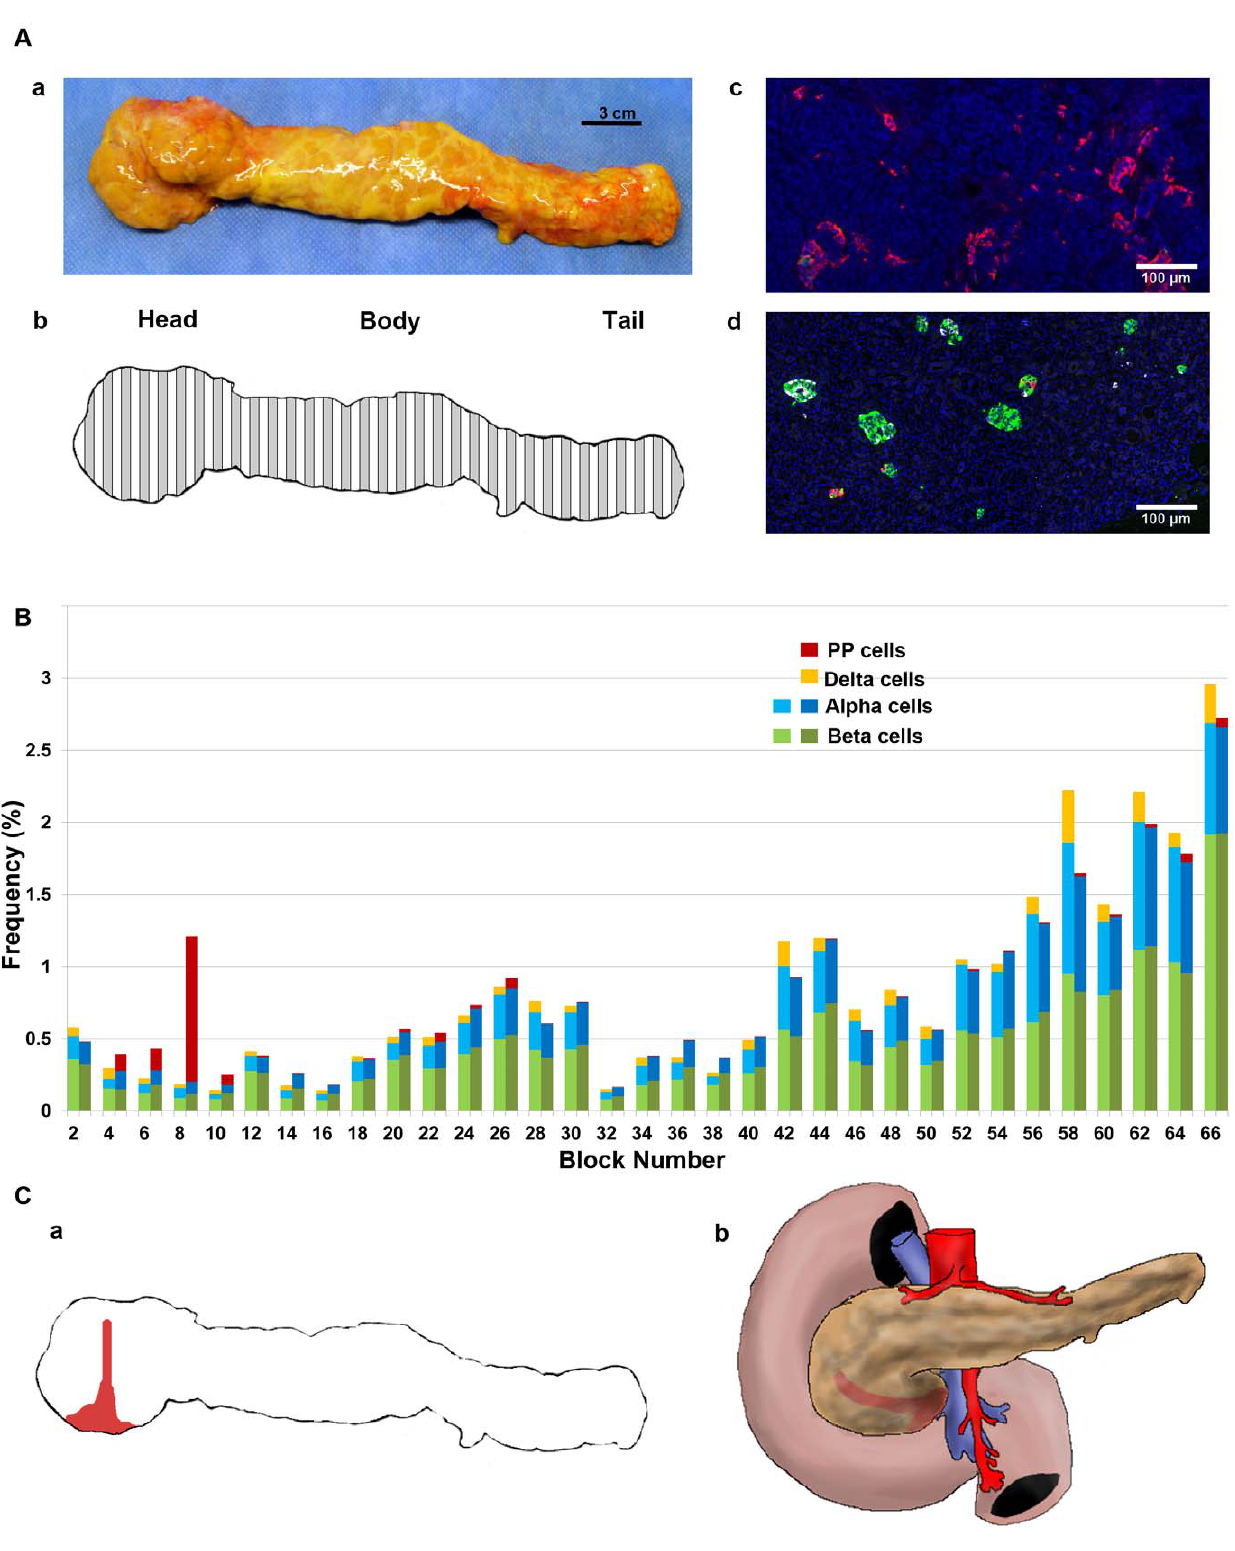
Figure 1. Whole pancreas analysis of the PP-cell distribution. A : a . A pancreas from a 50-yr old male; S5). b . Collection scheme. Specimen divided into 66 consecutive sections, with preparation alternating between fresh-frozen (white) and paraffin embedding (grey). The latter set of tissue blocks was used in the present study. c . Representative view of the PP-cell rich region with irregularly shaped clusters of PP-cells. Immunostained for PP (red), insulin (green), glucagon (white) and nuclei (blue). d . PP-cell poor area. B : Regional distribution of PP-, beta-, and alpha-cell mass. C : a . Restricted PP-cell rich area illustrated in red. b . Deduced PP-cell rich region in vivo .